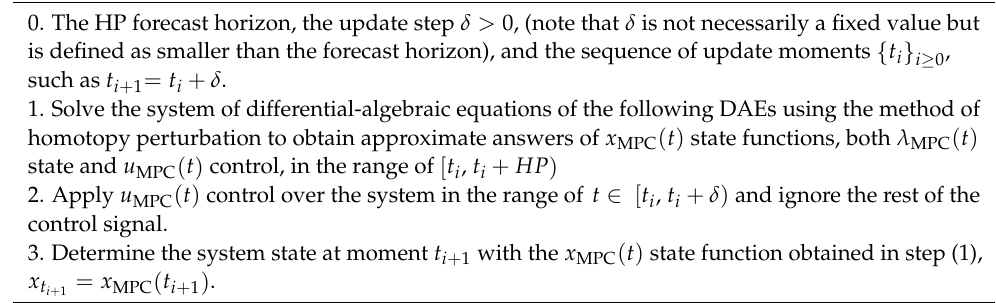
Algorithm 2: Predictive controller for the problem